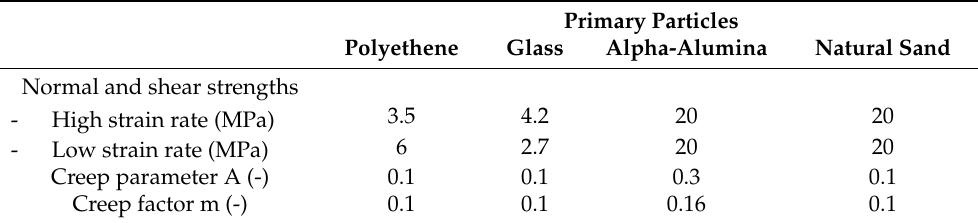
Table 4. Material properties for ice bonds used for modeling different agglomerates at different loading rates. Primary Particles Polyethene Glass Alpha-Alumina Natural Sand Normal and shear